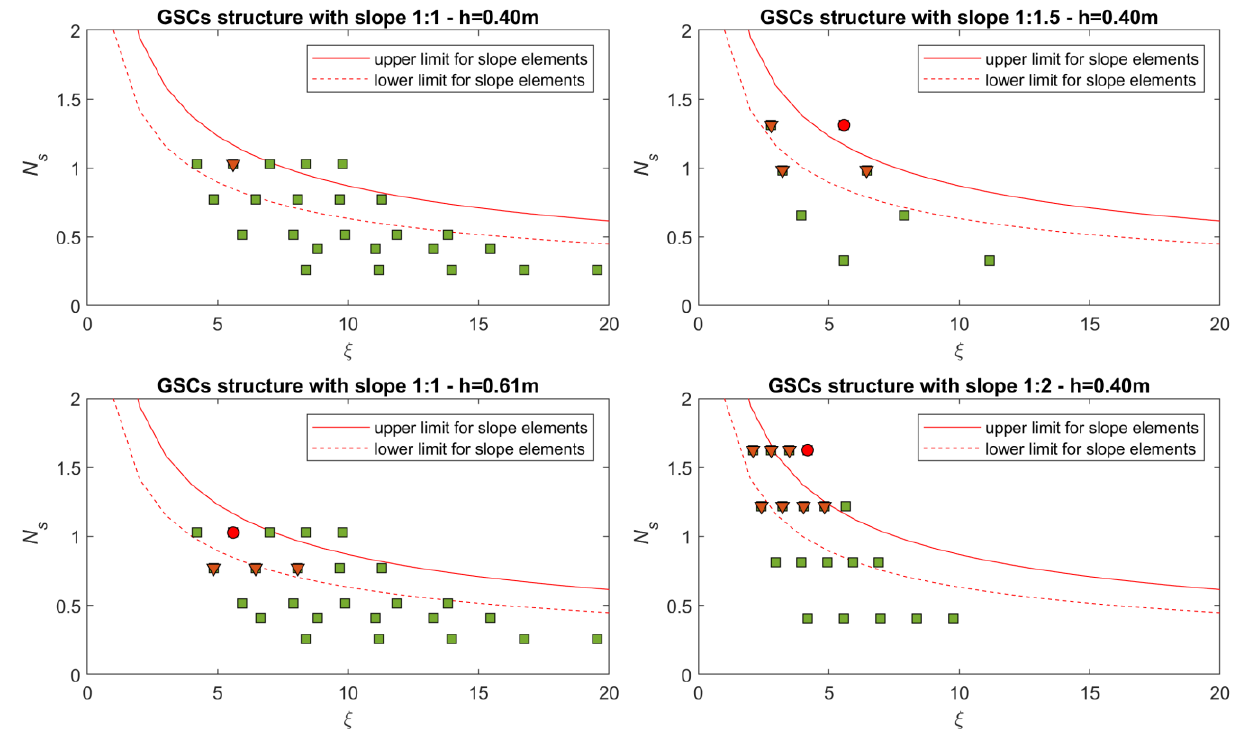
Figure 17. Stability number ns vs. Iribarren’s parameter. Experimental data and line trends of [33]. Stable elements in green squares, sliding elements in orange triangles and global instability of the structure in red circle.